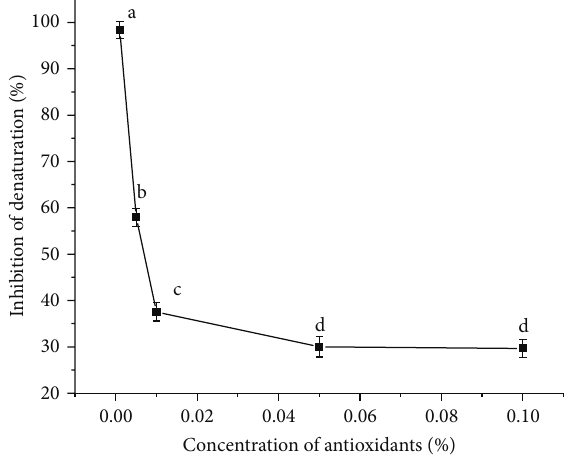
Figure 9: Inhibition of denaturation in vitro by 𝛼 - and 𝛽 -carotene crystals at different concentrations. Values are Mean ± SEM of 3 observations. At the 0.05 level, the difference in superscripts (a, b, c, d) indicates significant difference in